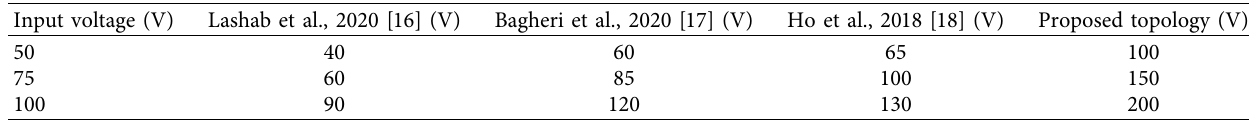
Table 4: Comparison of output voltages for various